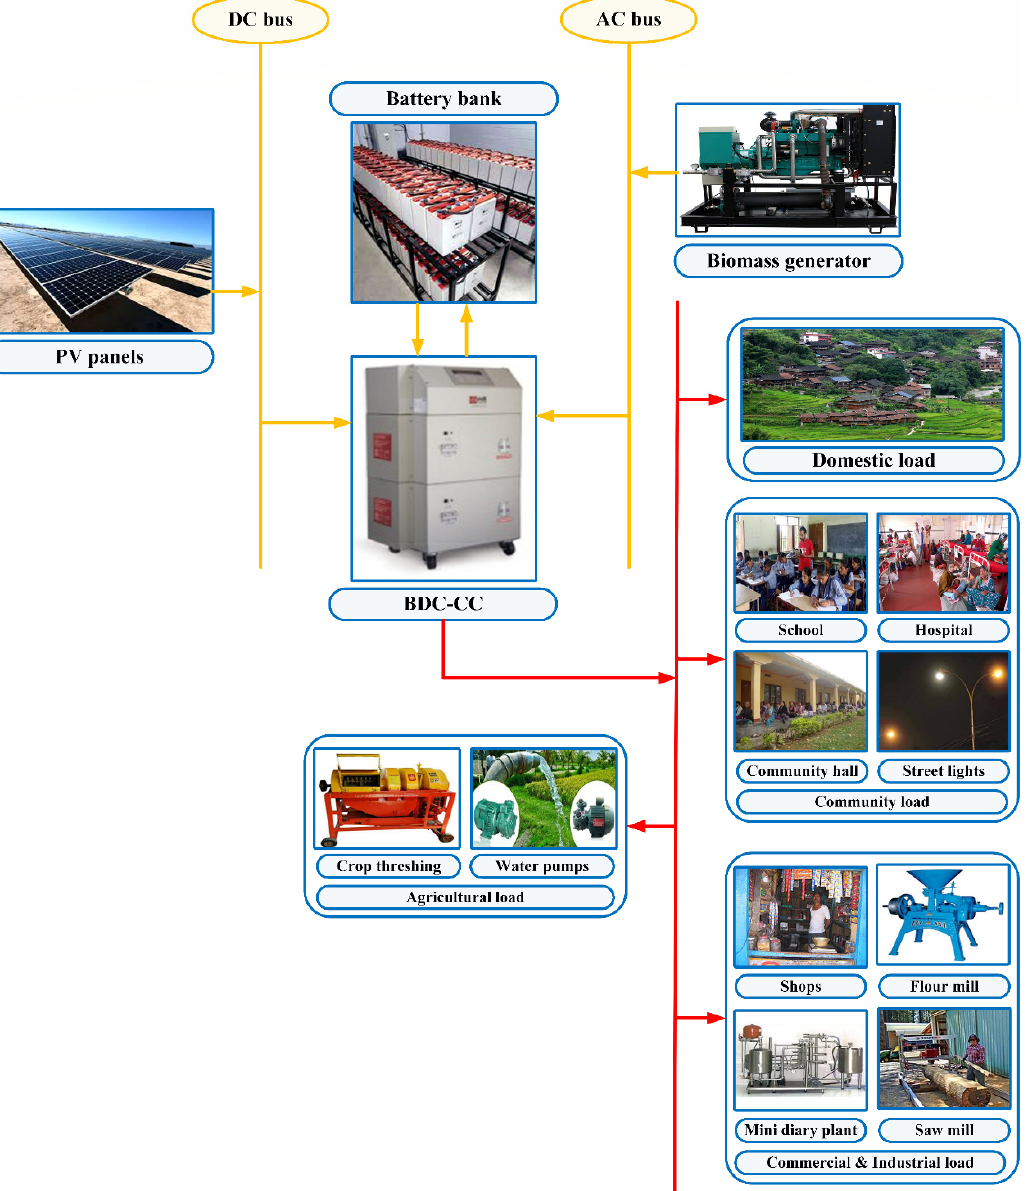
Figure 5. Schematic diagram of the study area electrification model.